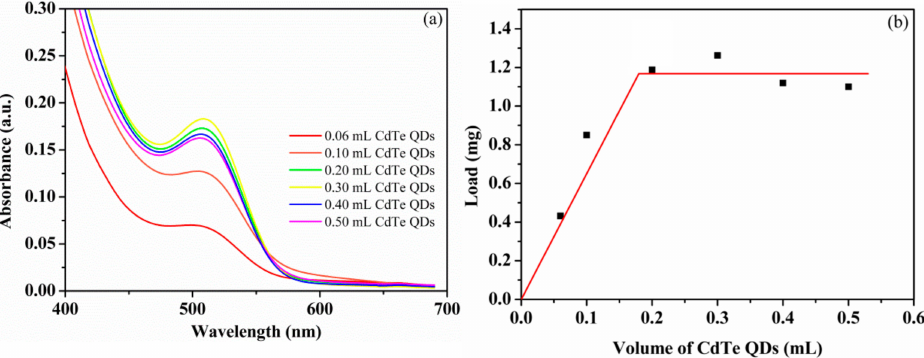
Figure 4. ( a ) UV–Vis spectra of CdTe QDs encapsulated by HPAMAM–DA by adding various volume of CdTe QDs and ( b ) determination of the average loads of CdTe QDs per 4 mg HPAMAM–DA from the absorption in the UV–Vis spectra. Volume of CdTe QDs: the volume of aqueous CdTe QDs added; Load: average load of CdTe QDs per 4 mg